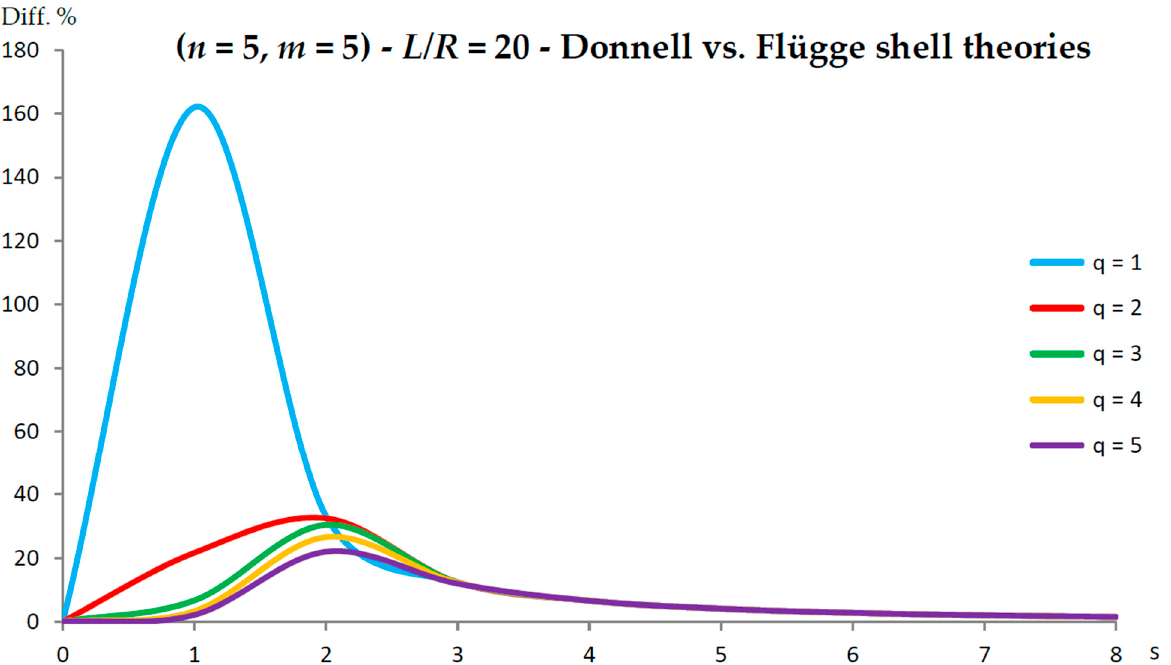
Figure 10. Percentage differences between the radial natural frequencies obtained via Donnell and Flügge shell theories (Flügge as the reference). Anisotropic elastic shell model. Simply supported SWCNT of Table 1 with chirality indices (𝑛 = 5, 𝑚 = 5) and aspect ratio 𝐿/𝑅 = 20 . Number of longitudinal half-waves 𝑞 . Number of circumferential waves 𝑠 .